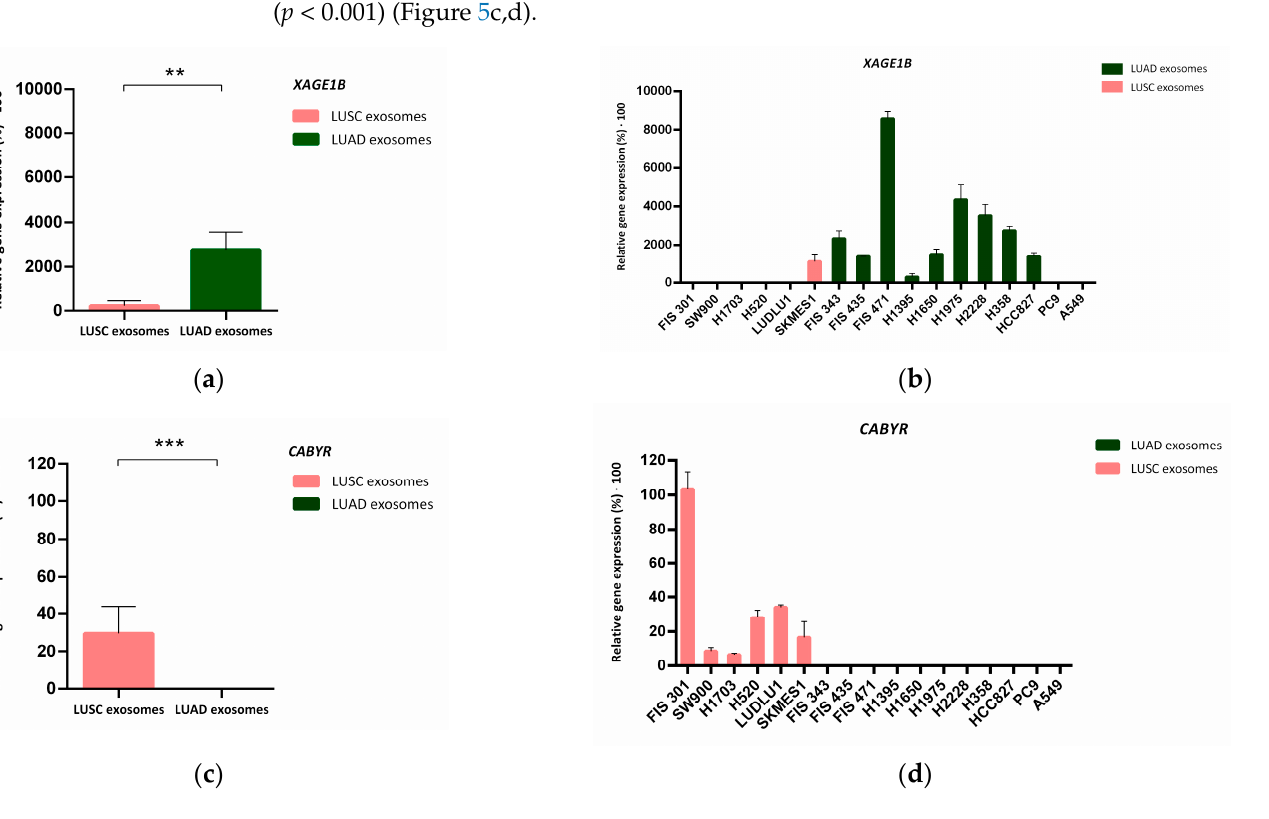
Figure 5. Validation of XAGE1B and CABYR expression in tumor-derived exosomes from 2D cell cultures. ( a – c ) Median of relative gene expression of XAGE1B and CABYR measured via RT-qPCR in both histological groups. Error bars represent SD. Dark green bars correspond to LUAD-derived exosomes while salmon bars correspond to exosomes derived from LUSC samples. ( b – d ) Mean with SD of de relative gene expression of XAGE1B and CABYR to reference genes ACTB and GAPDH analysed in the complete group of cell cultures-derived exosomes. Significance values were ** p ≤ 0.01, and *** p ≤ 0.001.